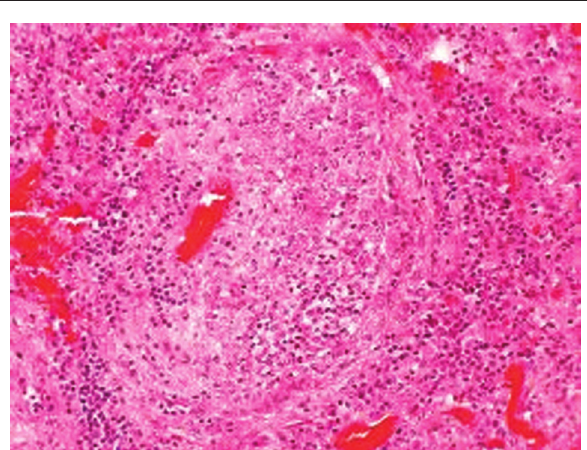
Histopathological examination of a resected specimen from the left upper lobe